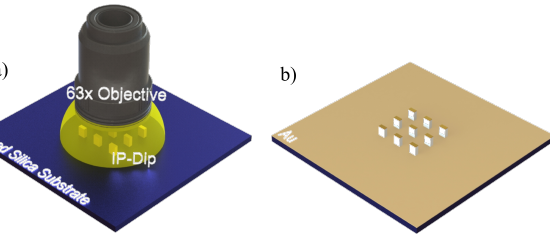
Figure 3. A schematic of the two-step fabrication method used to synthesize reciprocal plasmonic metasurfaces is shown. ( a ) Initially, rectangular fin arrays are additively manufactured using two- photon polymerization on a fused silica substrate. ( b ) Post-polymerization, the reciprocal metasurface sample is metalized using electron beam evaporation, simultaneously forming the top and bottom layers of the